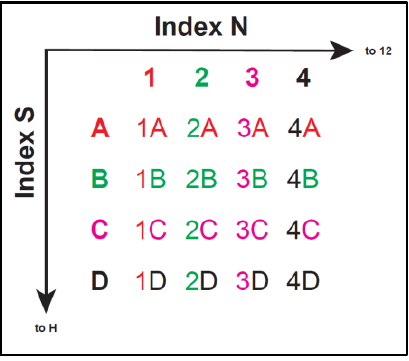
Figure 6. Exemplified sample alignment for MiSeq sequencing.